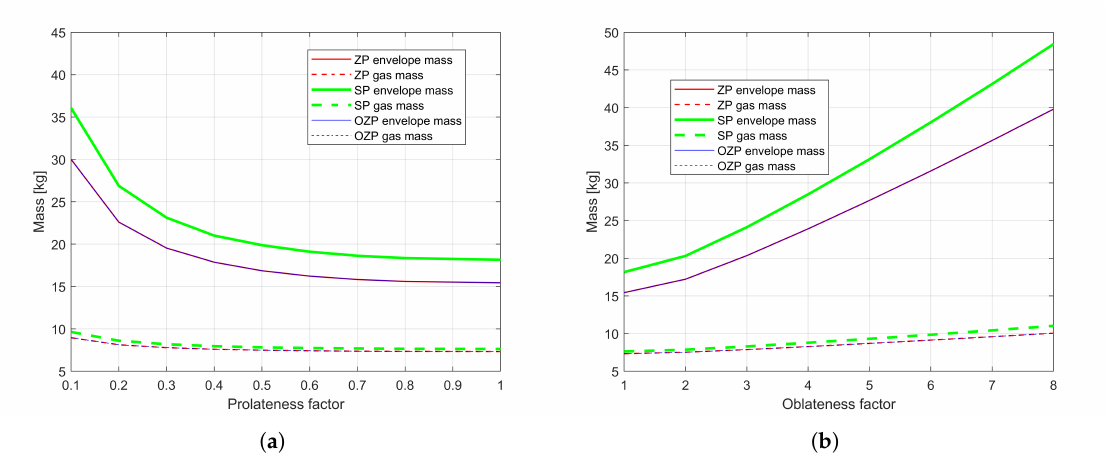
Figure 8. Mass variation of different balloon types at varying fineness ratio on Venus ( a ) Airship and Prolate ( b ) Oblate. Note that the lines for ZP gas mass and OZP gas mass are superimposed, as well as the lines for ZP envelope mass and OZP envelope mass.